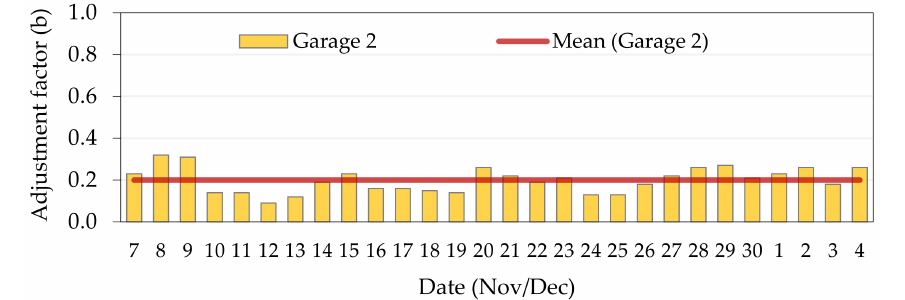
Figure 17. Daily variation of the adjustment factor (b) for Garage 2. Table 20. Values of the estimated adjustment factor (b) for Garage 2.